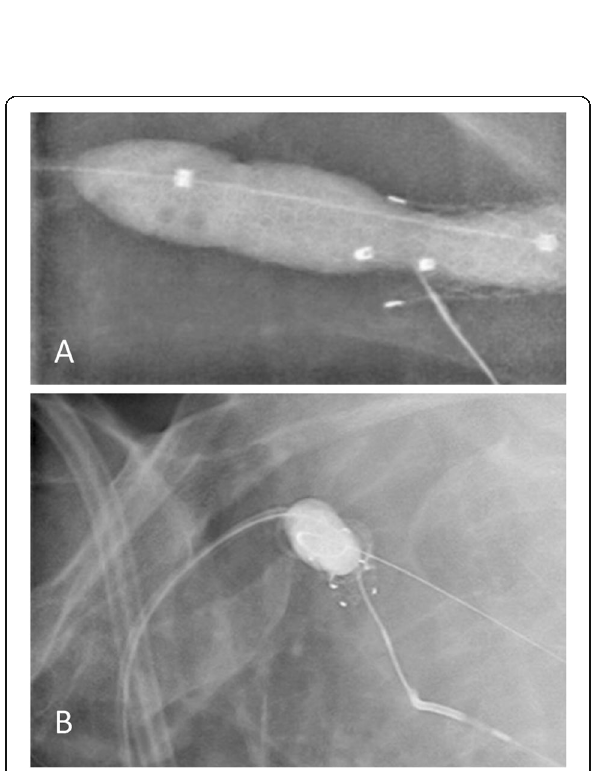
Fig. 4 Fluoroscopic images showing the drilling tip of the TruePath device (supported by a 4F Berenstein catheter and 0.018 ″ CXI support catheter),penetrating through the fabric of the cephalic arch stent graft using the in-situ 10×40mm Advance LP balloon as a target. a Conventional anterior-posterior (AP) frontal projection, and b , a near lateral projection with steep cranio-caudal angulation to create a ‘ tunnel ’